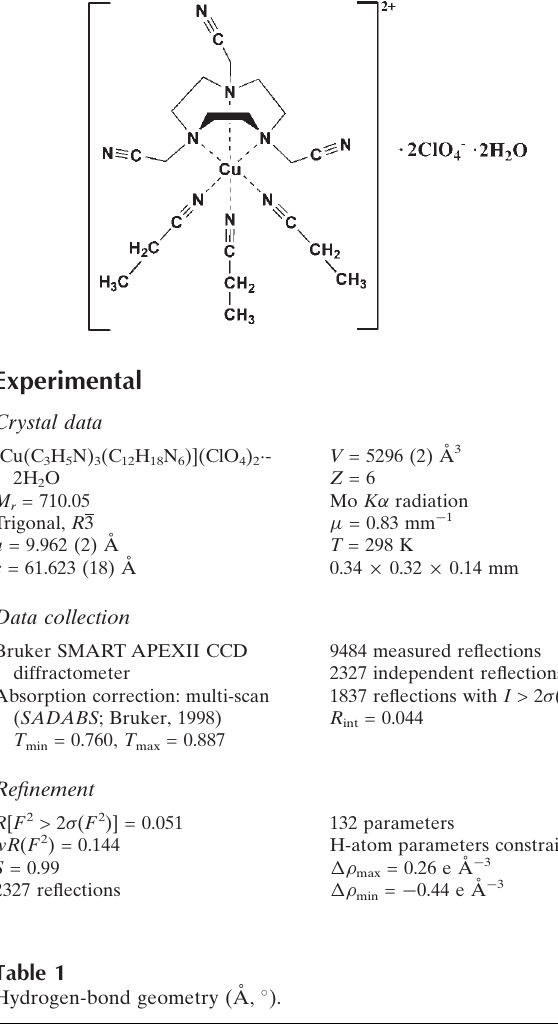
Hydrogen-bond geometry (A˚ , (cid:5)